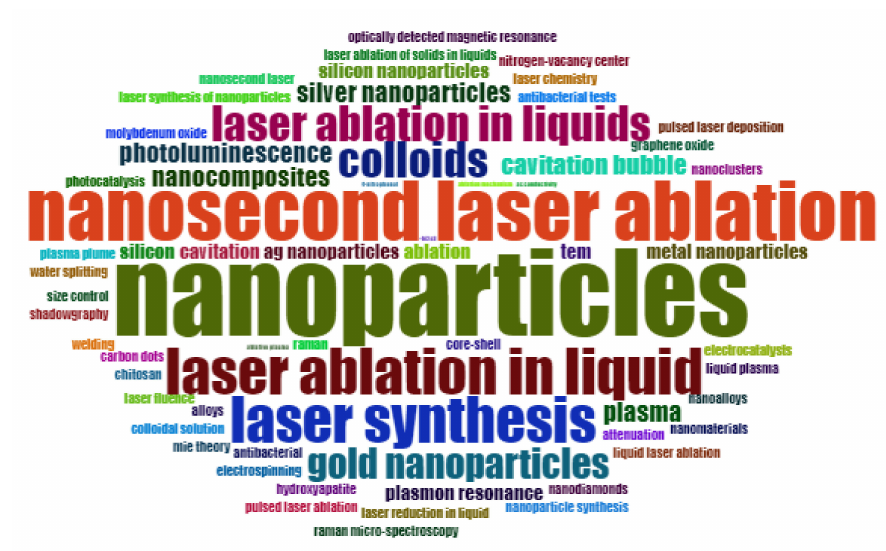
Figure 2. Bibliometric analysis of keywords related to pulsed laser ablation in liquid medium found in the literature using word cloud